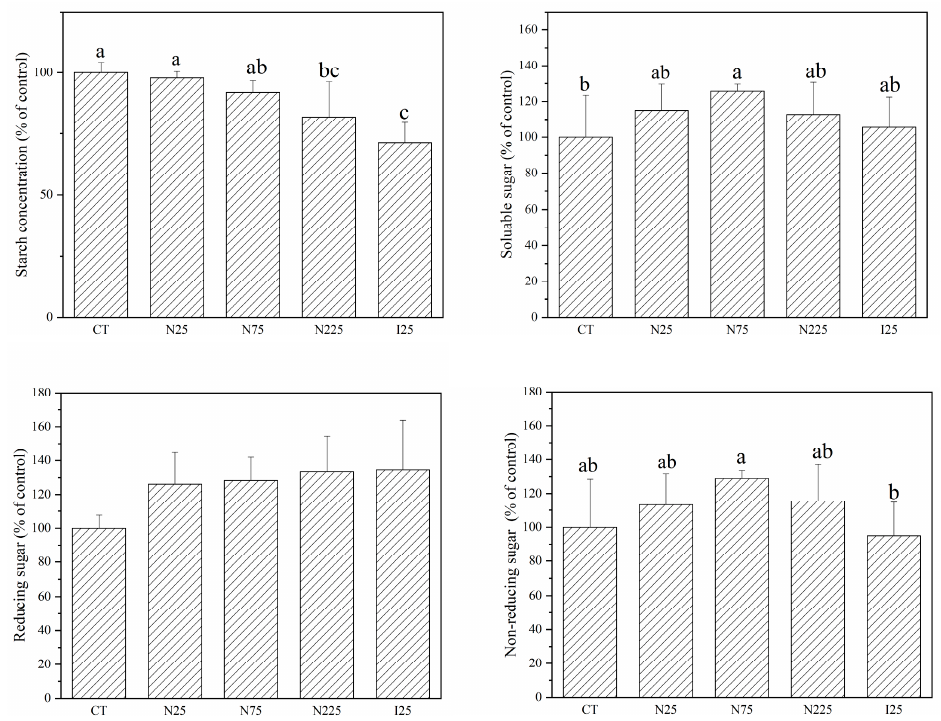
Figure 2. Contents of starch, soluble sugar, reducing sugar, and non-reducing sugar in the corn kernels harvested from plants cultivated in CeO 2 NPs/CeCl 3 -amended soil. CT: control; N: CeO 2 NPs; I: CeCl 3 . Different letters stand for statistical differences between treatments at p ≤ 0.05.